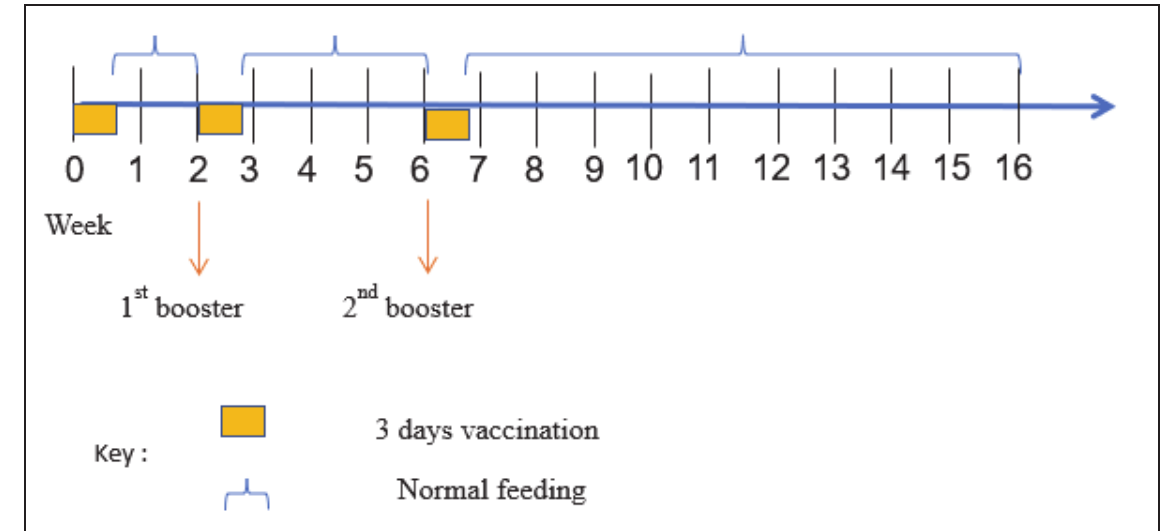
Figure 1. Experimental design and vaccination regimen using the feed-based vaccine against